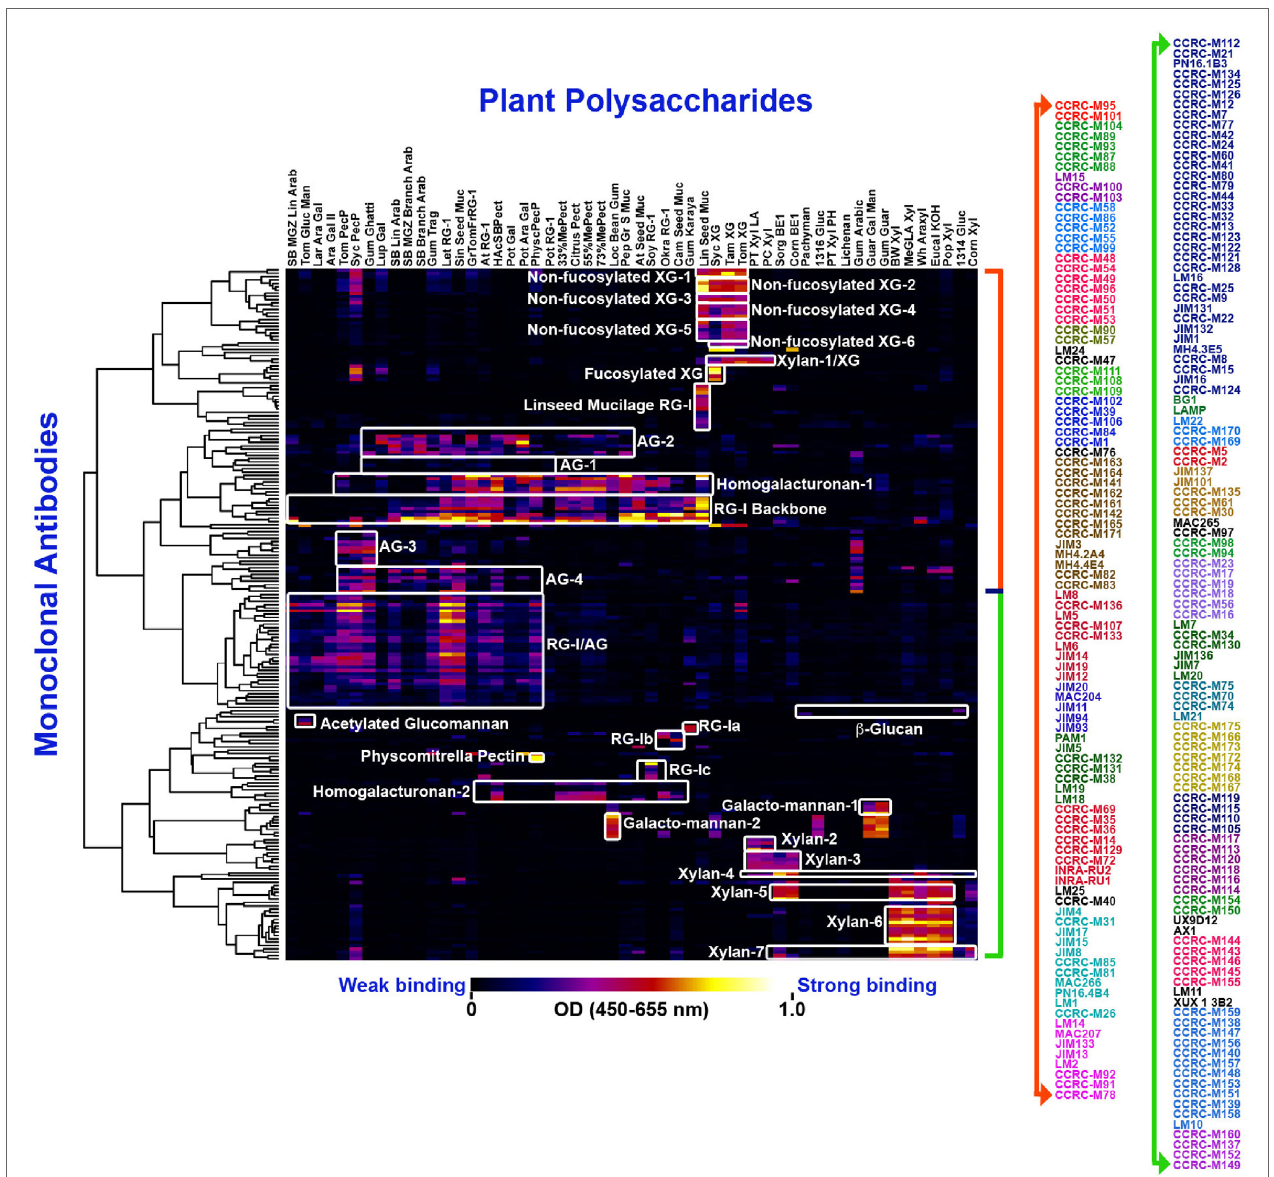
FiGURe 1 | Current worldwide collection of plant cell wall glycan-directed McAbs: the entire collection of ~210 McAbs was eLiSA-screened against a panel of 54 structurally known plant cell wall carbohydrate preparations ( Pattathil et al., 2010 ) and they were clustered to 31 groups (as depicted by the white blocks) based on their binding specificities . The binding strengths are depicted in a dark blue–red–bright yellow color scheme where maximum and no binding are denoted by bright yellow color and dark blue colors, respectively. The names of individual McAbs are denoted on the right hand panel in different colors denoting 31